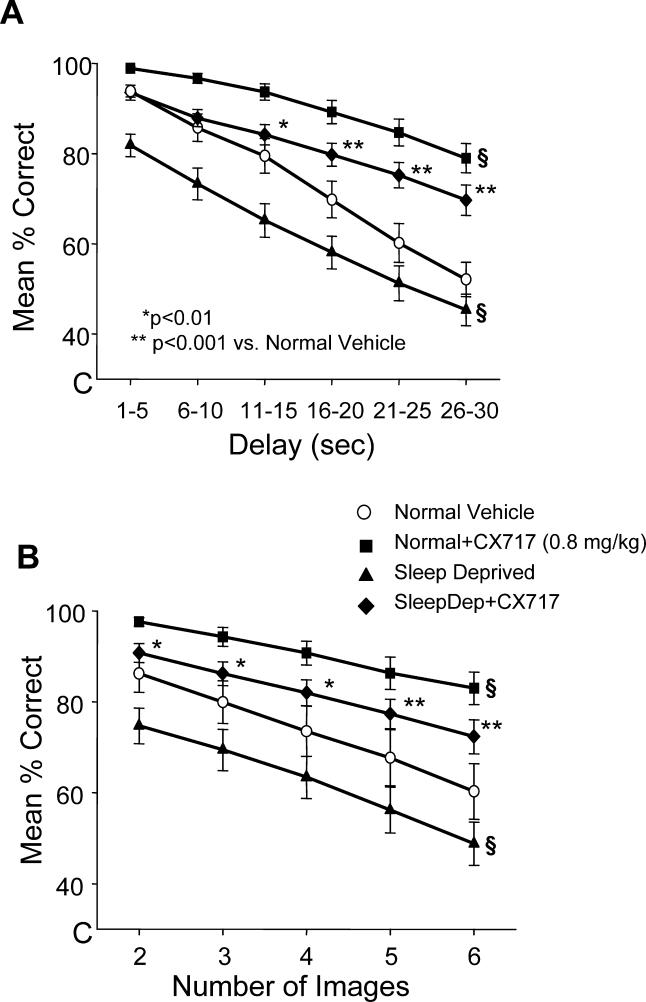
Separation of Effects of Sleep Deprivation + CX717 on DMS Performance Parameters, Delay Versus Number of Images(A) Mean (± SEM) percent correct performance across animals on DMS trials sorted by delay (1–30 sec, in 5 s increments) and summed over two to six image trials for normal vehicle, normal + CX717, sleep deprivation, and sleep deprivation + CX717 conditions (separate curves). Data are the same as shown in Figures 2 and 4.(B) Mean (± SEM) percent correct performance for DMS trials partitioned by number of images and summed over 1–30 s delays for the same four treatment conditions shown in (A).Asterisks indicate separation limits for significant differences (*p < 0.01, **p < 0.001) of CX717 and sleep deprivation means compared to the normal vehicle mean; § symbol indicates that all points on the indicated curve differ significantly from all points on normal vehicle curve.DOI: 10.1371/journal.pbio.0030299g005